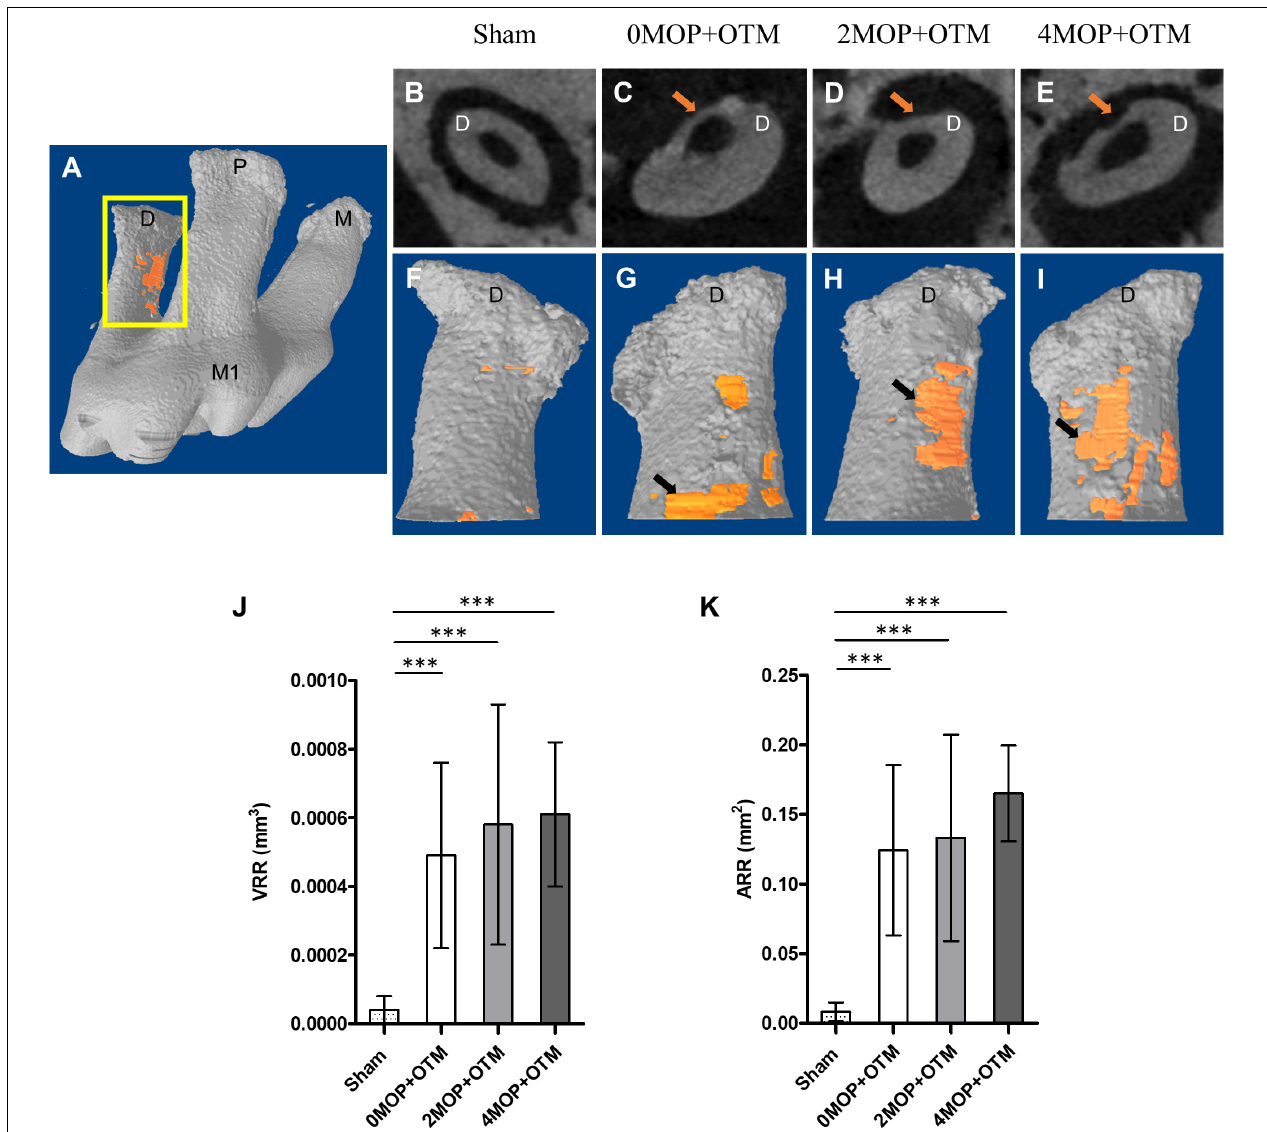
FIGURE 2 | Micro-CT analysis for root resorption. (A) Maxillary right 1st molar, and the segment of the distal root that was analyzed for root resorption. View of the axial section at which the crater ( arrow ). (F–I) 3D reconstructed images of distal root mesial side with crater ( orange ) for each group based on (B–E) . (J) The volumetric analysis shows the VRR, mm 3 in the 0MOP+OTM group averaged (0.00049 ± 0.00027 mm 3 ), while those in the 2MOP+OTM group were (0.00058 ± 0.00035 mm 3 ), and those in the 4MOP+OTM group averaged (0.00061 ± 0.00021 mm 3 ). (K) In terms of measured ARR, mm 2 that of the 0MOP+OTM group averaged (0.12 ± 0.06 mm 2 ), the 2MOP+OTM group averaged (0.13 ± 0.07 mm 2 ), and the 4MOP+OTM group (0.14 ± 0.05 mm 2 ). These results were not significant between experimental groups. The Sham group’s value for VRR, mm 3 (0.00004 ± 0.00004 mm 3 ; p < 0.001), and ARR, mm 2 (0.008 ± 0.007 mm 2 ; p < 0.001) were decreased compared to those of the other groups. ( N = 12 for each group) (M1, 1st molar; M, mesial; P, palatal; D, distal; arrow, indicate root resorption; data are expressed as means ± standard deviations. Tested by Mann–Whitney U test, at ∗∗∗ p <